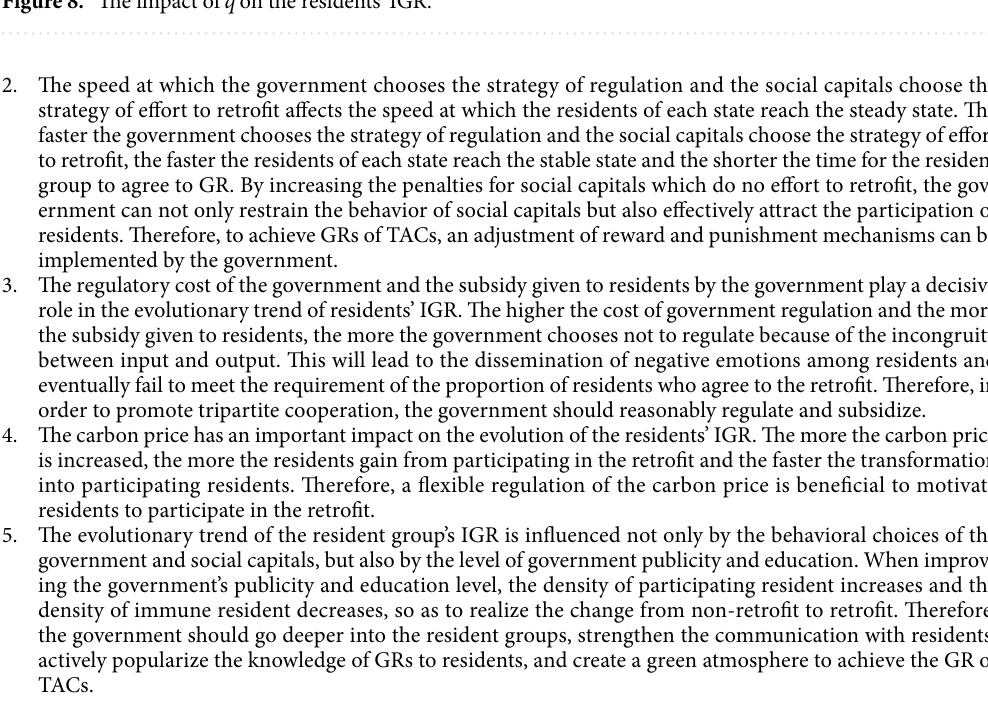
Figure 8. The impact of q on the residents’